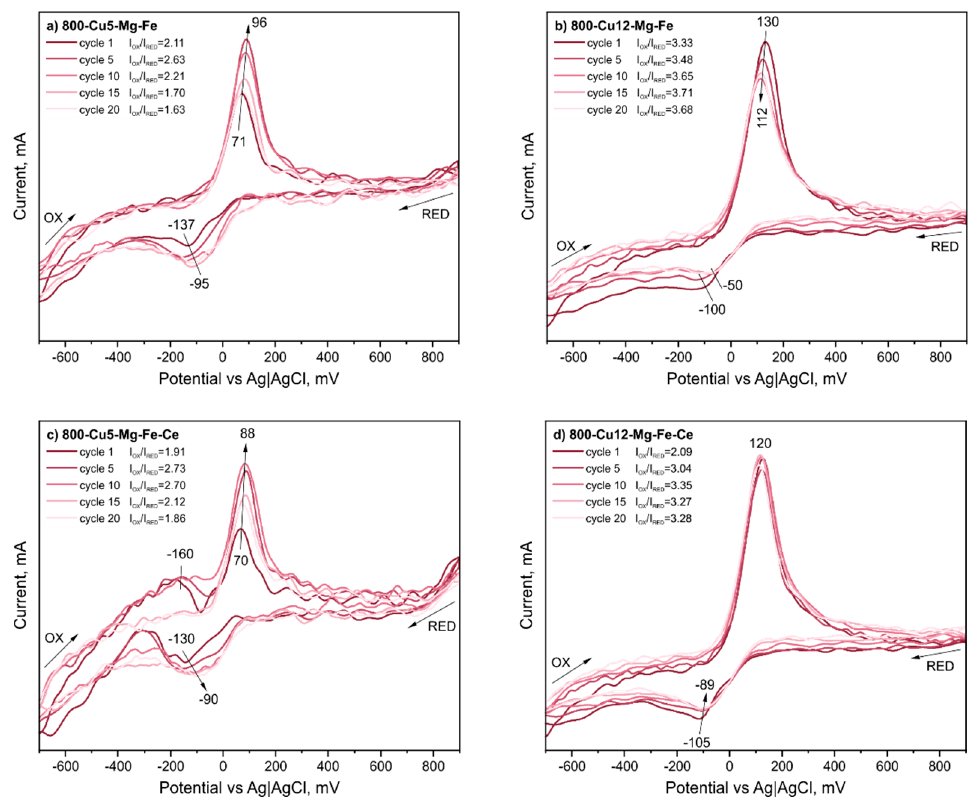
Figure 6. CV multi-cyclic curves registered for catalysts ( a ) 800-Cu5-Mg-Fe, ( b ) 800-Cu12-Mg-Fe, ( c ) 800-Cu5-Mg-Fe-Ce, ( d ) 800-Cu12-Mg-Fe-Ce; OX—oxidation curve, RED—reduction curve; direction of potential change for OX and RED curves is described by arrows; I OX , I RED —intensity of oxidation and reduction signal, respectively.